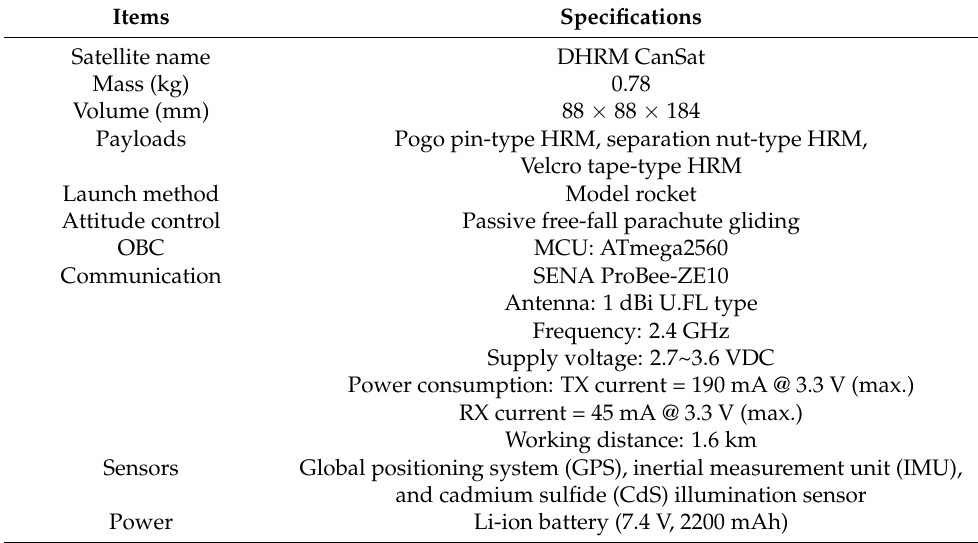
Figure 1. System architecture and operation concept for the DHRM CanSat mission. Table 1. System specifications of the DHRM CanSat.